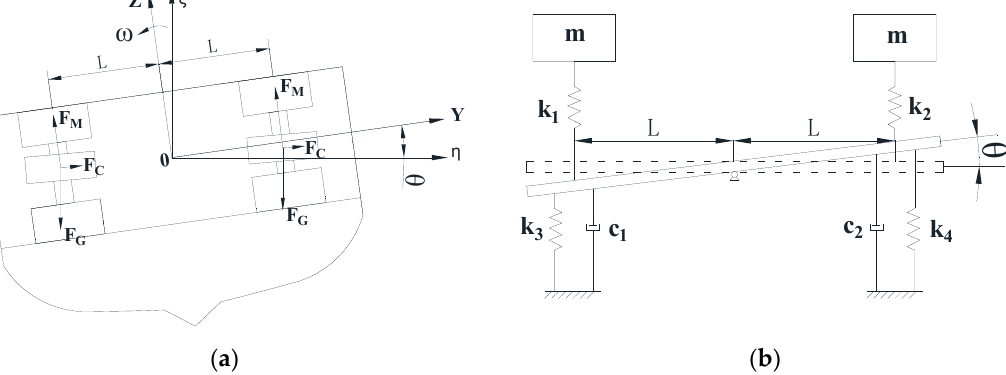
6 of 16 Figure 5. Acceleration and inertia force simulation diagrams of mass block at different frequencies. ( a ) Acceleration diagram;( b ) inertia force diagram.